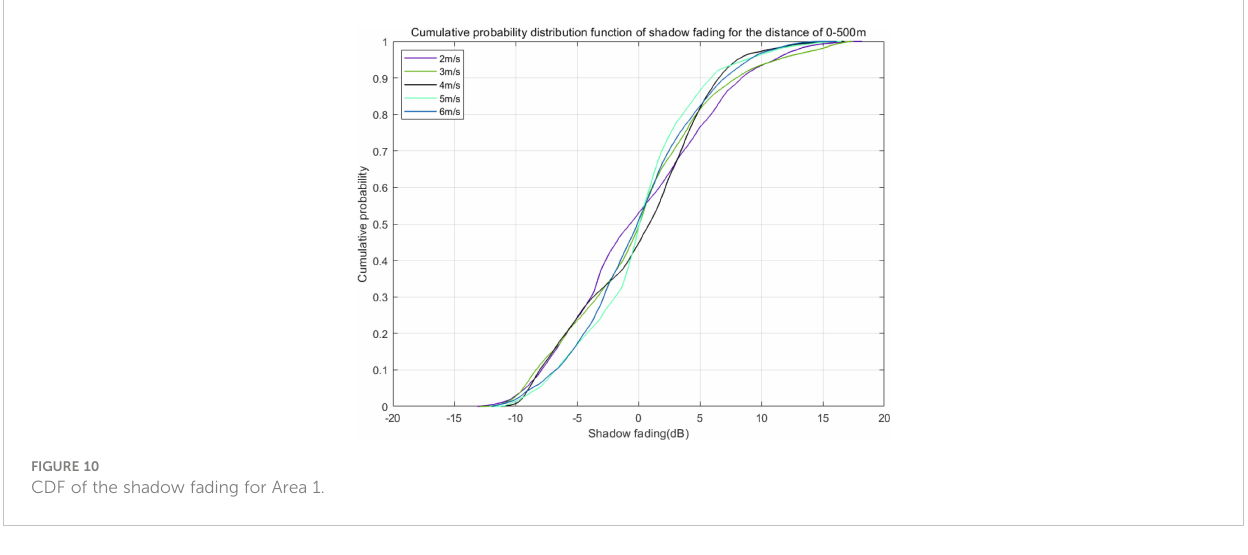
TABLE 3 Statistic results.